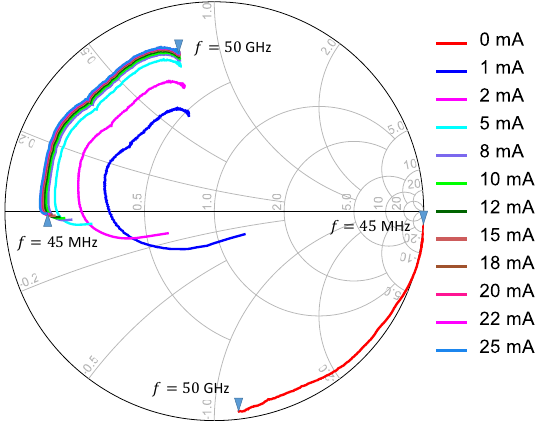
Figure 3. Measured S-parameter (de-embedded) vs.